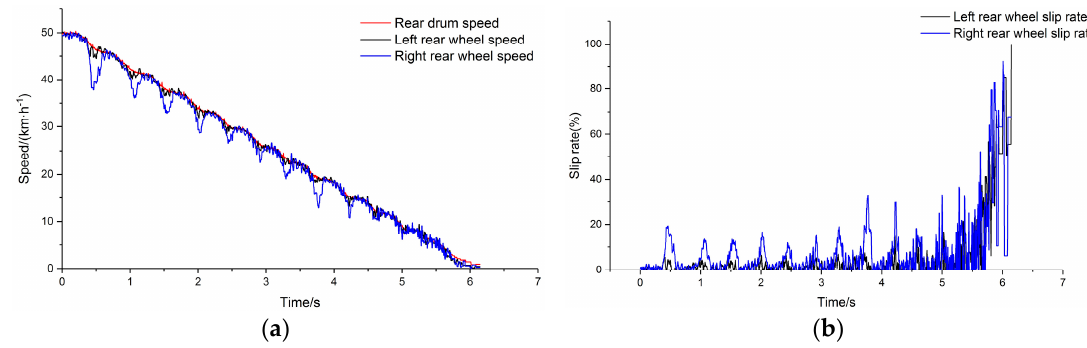
Figure 18. ( a ) Comparison of main drum speed and wheel speed; ( b ) slip rate.